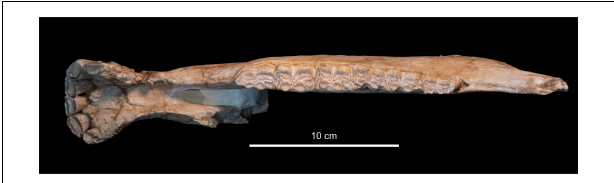
FIGURE 3 | MPGJ 1683 of Zac Tab 34 Wang Location, ventral view of the jaw, symphysis and incisors are complete, the incisors have wide infundibulum, the linguaflexid is wide, the metacónid and metastilid are lobular, the lingual edge of the protoconid and hypoconid is